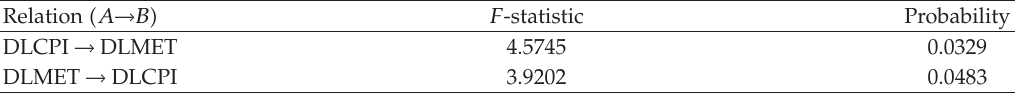
Table 1: Test for nonlinear causality (cid:5) symmetric case (cid:6) . If P > . 05, then at 5% we accept the null hypothesis that A does not cause B . The parameters for the M-G model were τ 1 (cid:8) 3, τ 2 (cid:8) 1, and c 1 (cid:8) c 2 (cid:8) 2.